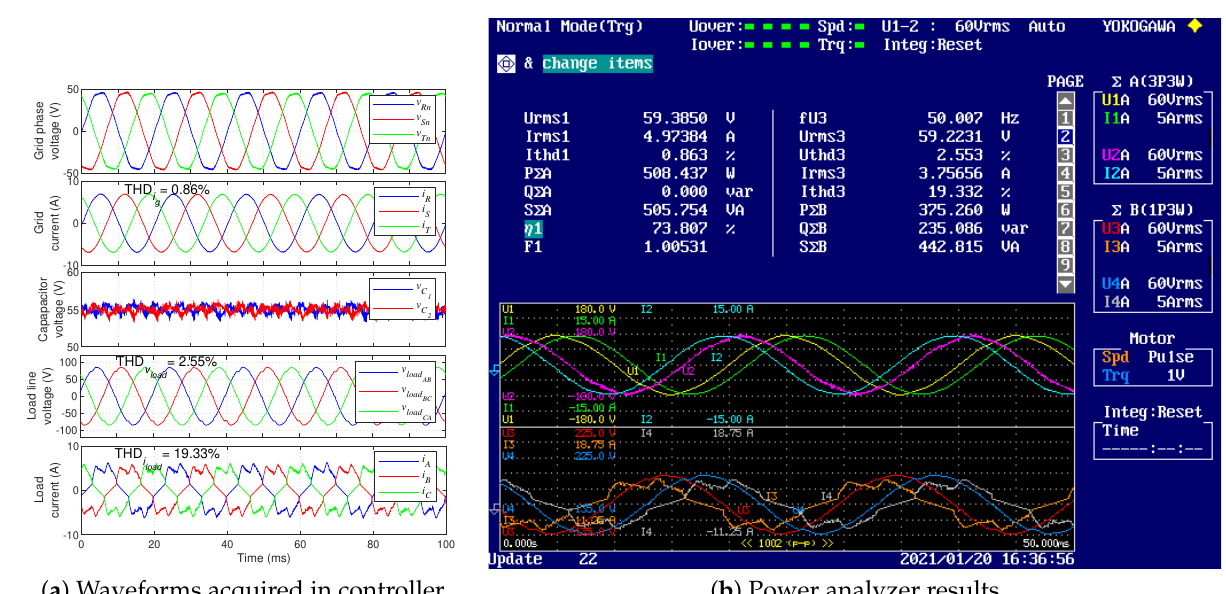
Figure 12. Normal UPS operation with a non-linear load.